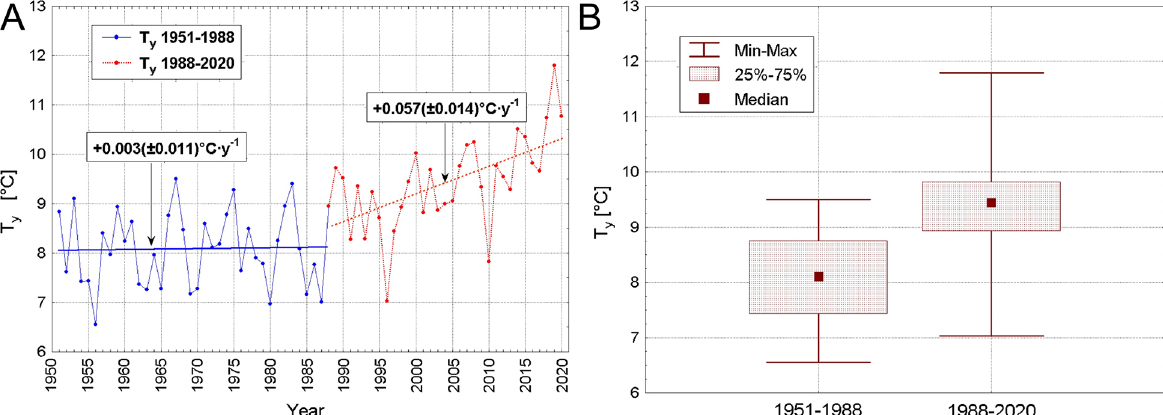
Fig. 2. The annual air temperature (T ) with values of linear trends and the standard error of their estimation y (in brackets) (A), and its variability ranges (B) in Poznań in sub-periods 1951–1988 and